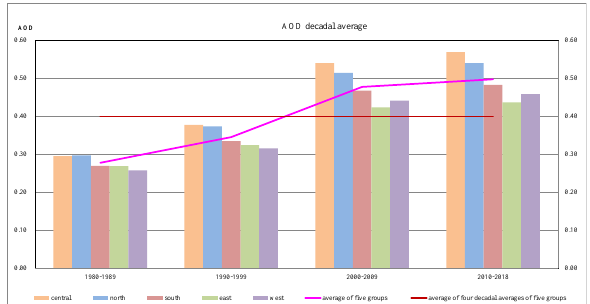
Figure 7. The comparison among AOD decadal average of the five groups